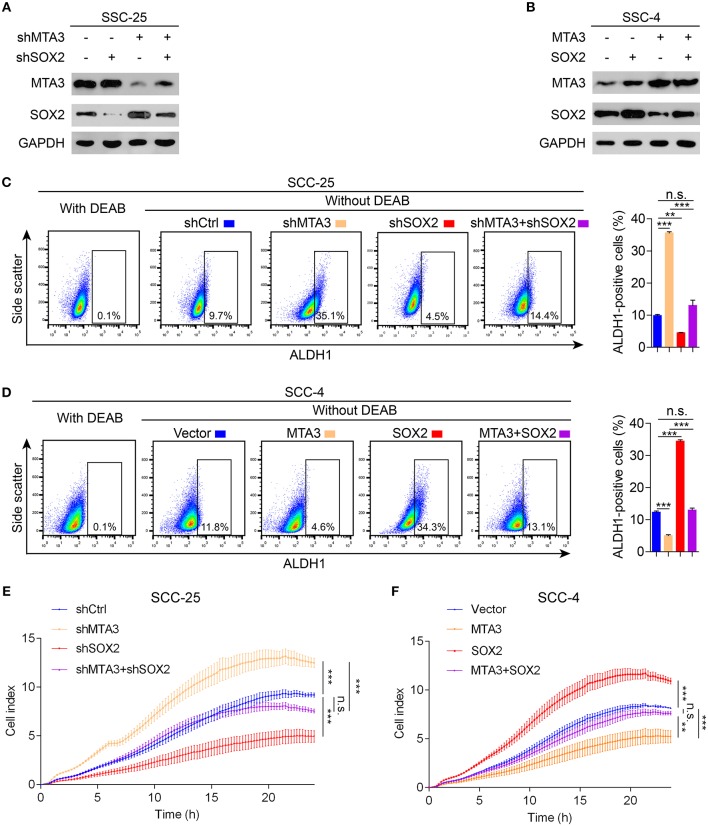
MTA3 reduces CSC properties and cell proliferation via SOX2 in TSCC cells. (A,B) Western blot and qRT-PCR in TSCC cells transfected with a combination of shMTA3 and shSOX2 (A) or MTA3 and SOX2 expressing plasmid (B). (C,D) Flow cytometry analysis of the ALDH1+ population. Histograms showing the proportion of ALDH1+ cells. (E,F) Cells were monitored by RTCA for 24 h. Data were shown as the means of three independent experiments or representative data. Error bars indicate SEM. n.s., not statistically significant; **P < 0.01, ***P < 0.001 by two-way ANOVA followed by a Tukey–Kramer post hoc test.